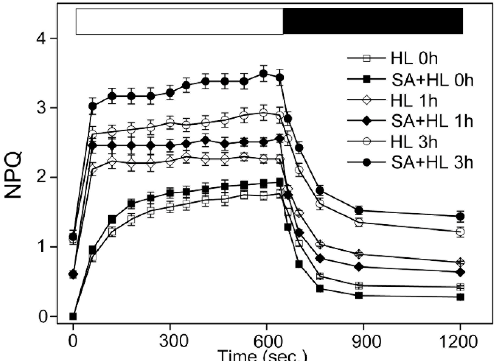
Figure 3. NPQ kinetics of Arabidopsis thaliana under high light. Bars on top, white bar (light on) and black bar (dark). The data represent means ± SD from four independent biological replicates ( n = 4). HL, high light. SA + HL, high light after SA pretreatment for 3 d. 0–3 h, high light for 0 h, 1 h, and 3 h in the presence or absence of SA pretreatment, respectively.